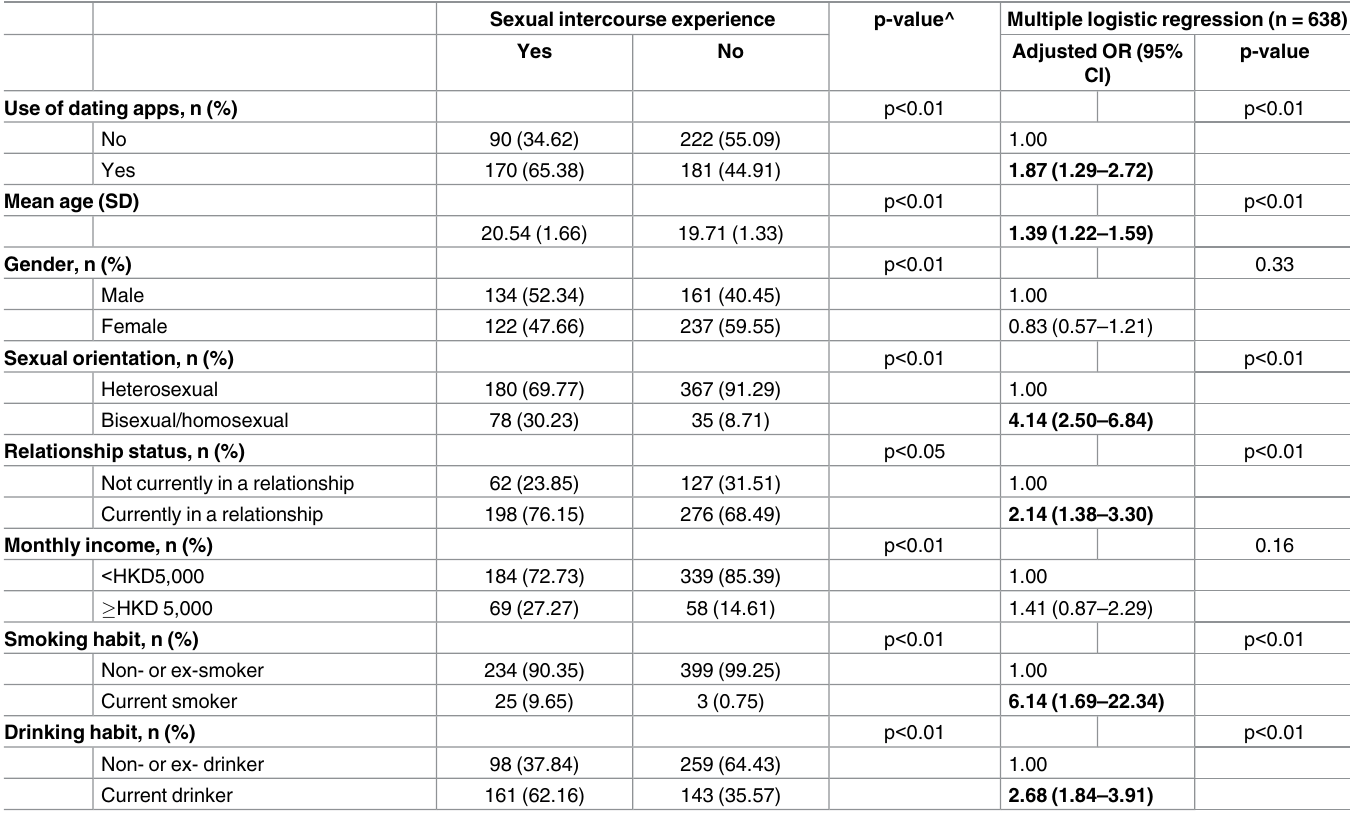
Table 2. Correlates of having sexual intercourse